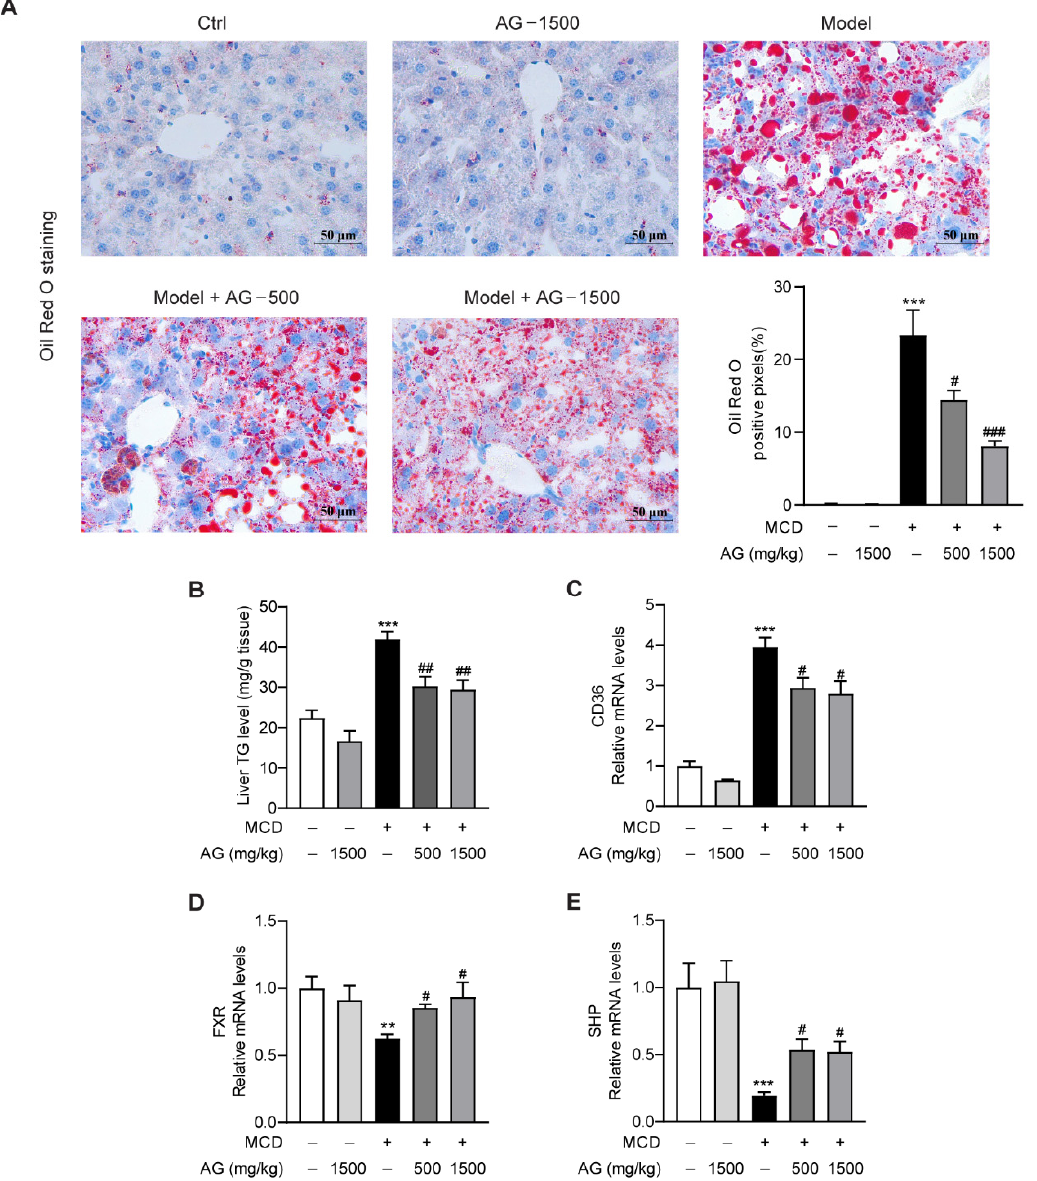
Figure 2. Effects of Ala-Gln on lipid metabolism in MCD-fed mice. ( A ) Oil Red O staining ( × 400) images in liver tissues; quantification of Oil-Red-O-positive area. ( B ) Liver TG level, ( C ) CD36, ( D ) FXR, and ( E ) SHP mRNA expression in liver. Data are expressed as the mean ± SEM. ** p < 0.01, *** p < 0.001, compared to the Ctrl group; # p < 0.05, ## p < 0.01, ### p < 0.001, compared to the Model